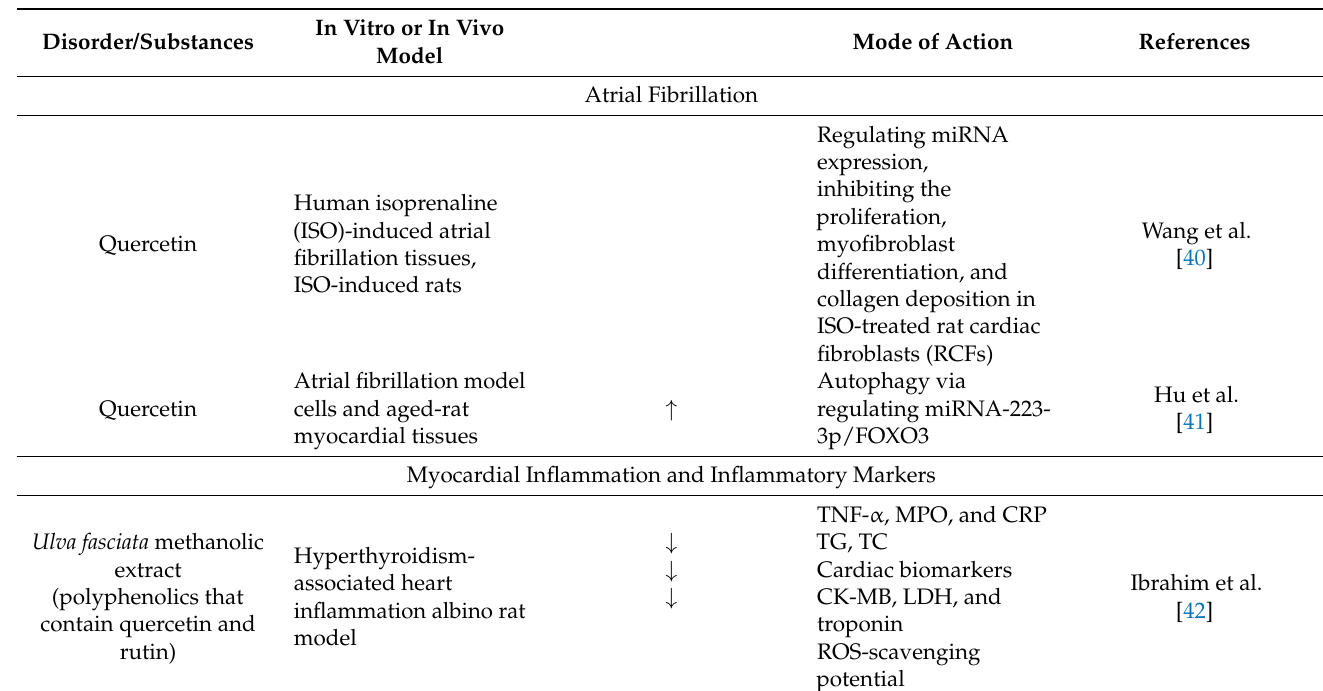
Table 2. In vivo and in vitro research update (studies published in 2021) on flavonols and their cardioprotective effects in pathological